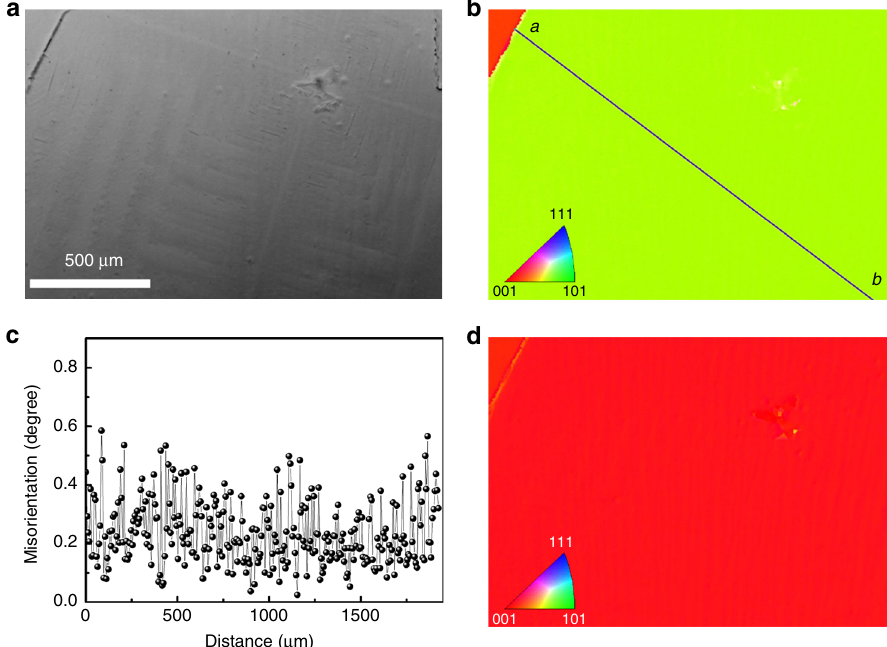
Fig. 3 Electron backscatter diffraction (EBSD) of the large-grain MAPbI 3 fi lm. a Backscattered electron (BSE) image. b X axis inverse pole fi gure (IPF) (parallel to the sample surface). c Point-to-point misorientation pro fi le along the black line from a to b in b . d Z axis inverse pole fi gure (normal to the sample surface). The scale bar in a also applies to b , d